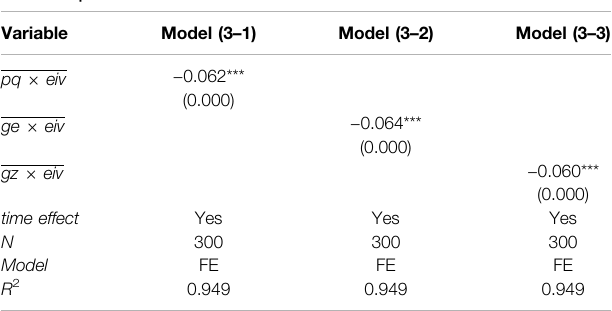
TABLE 5 | Extension results.